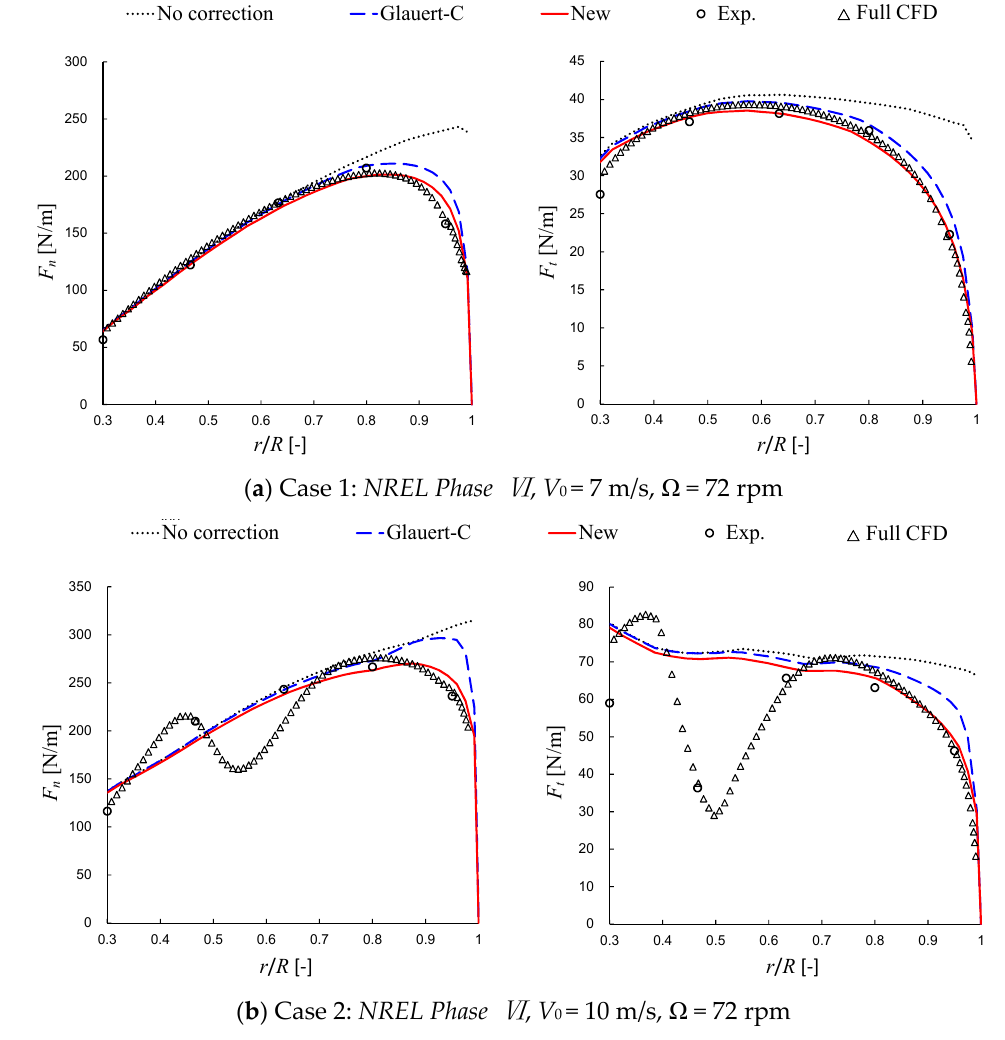
△ Full CFD Figure 8. Cont